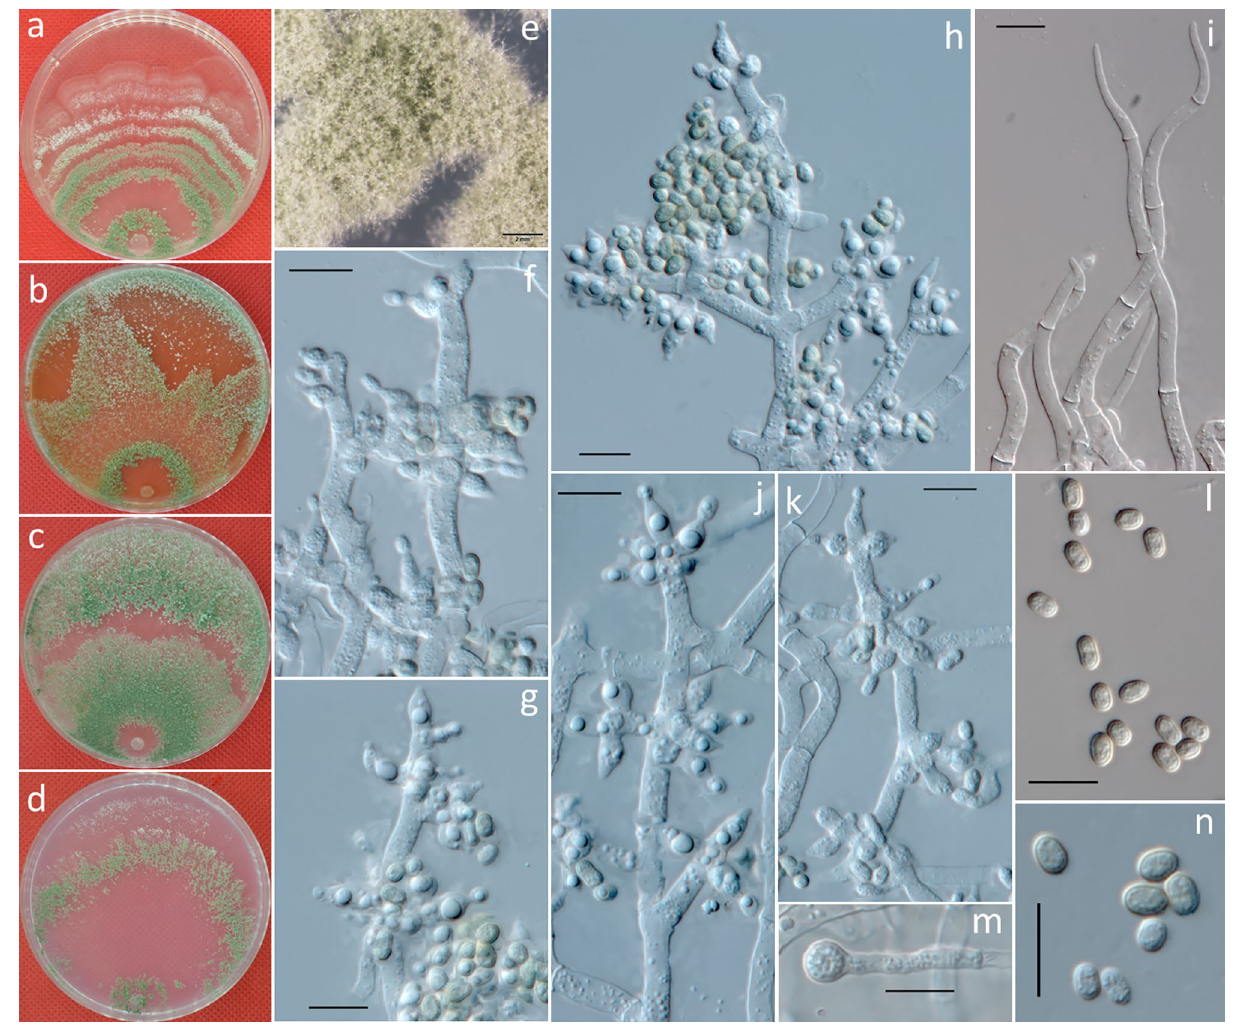
Figure 10. Cultures and asexual morph of Trichoderma rossicum . ( a–d ) Cultures after 7 days at 25 °C [( a ) on CMD; ( b ) on MEA; ( c ) on PDA; and ( d ) on SNA]. € Conidiation tuft (PDA, 7 days). ( f–h,j,k )